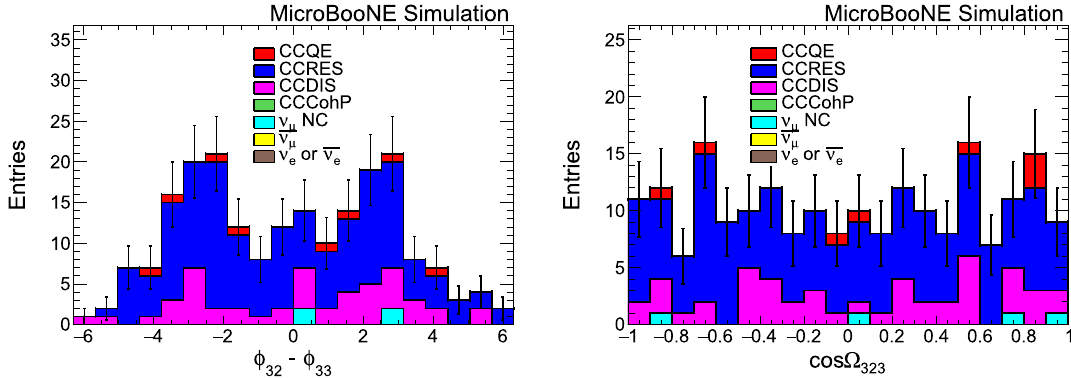
Fig. 39 Multiplicity = 3 φ 2 − φ 3 distribution (left); cosine of opening angle distribution between second and third track (right) from GENIE default MC. Black error bars represent MC statistical